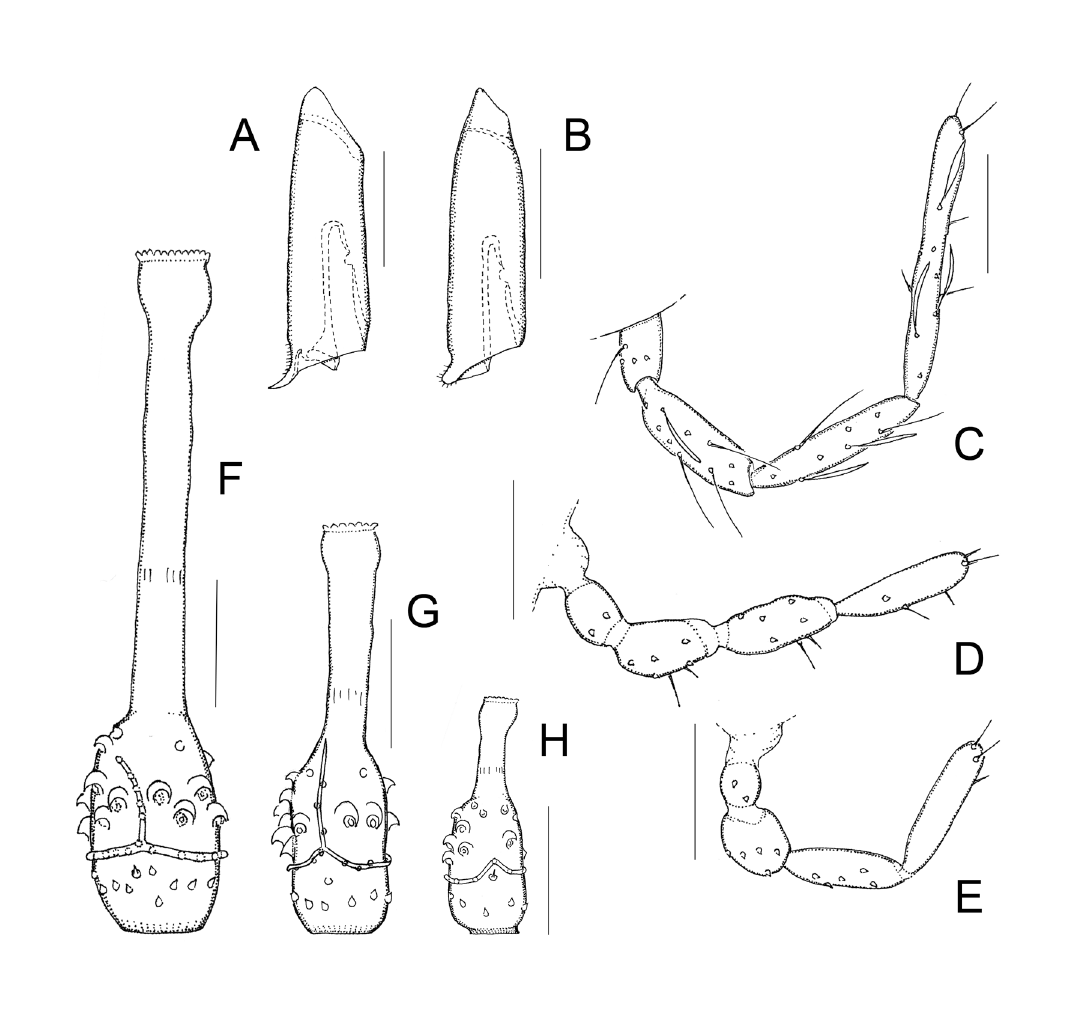
Fig. 1. Morphology of Glemparon spp., ♂♂. A . Basitarsus of foreleg in G. manuka sp. nov., lateral. B . Basitarsus of foreleg in G. warra sp. nov., lateral. C . Palpus of G. orautahi sp. nov., lateral. D . Palpus of G. tomelilla sp. nov., lateral, holotype. E . Palpus of G. tomelilla sp. nov., lateral, paratype. F . Fourth flagellomere of G. manuka sp. nov., lateral. G . Fourth flagellomere of G. orautahi sp. nov., lateral. H . Fourth flagellomere of G. tomelilla sp. nov., lateral. Scale bars = 0.05